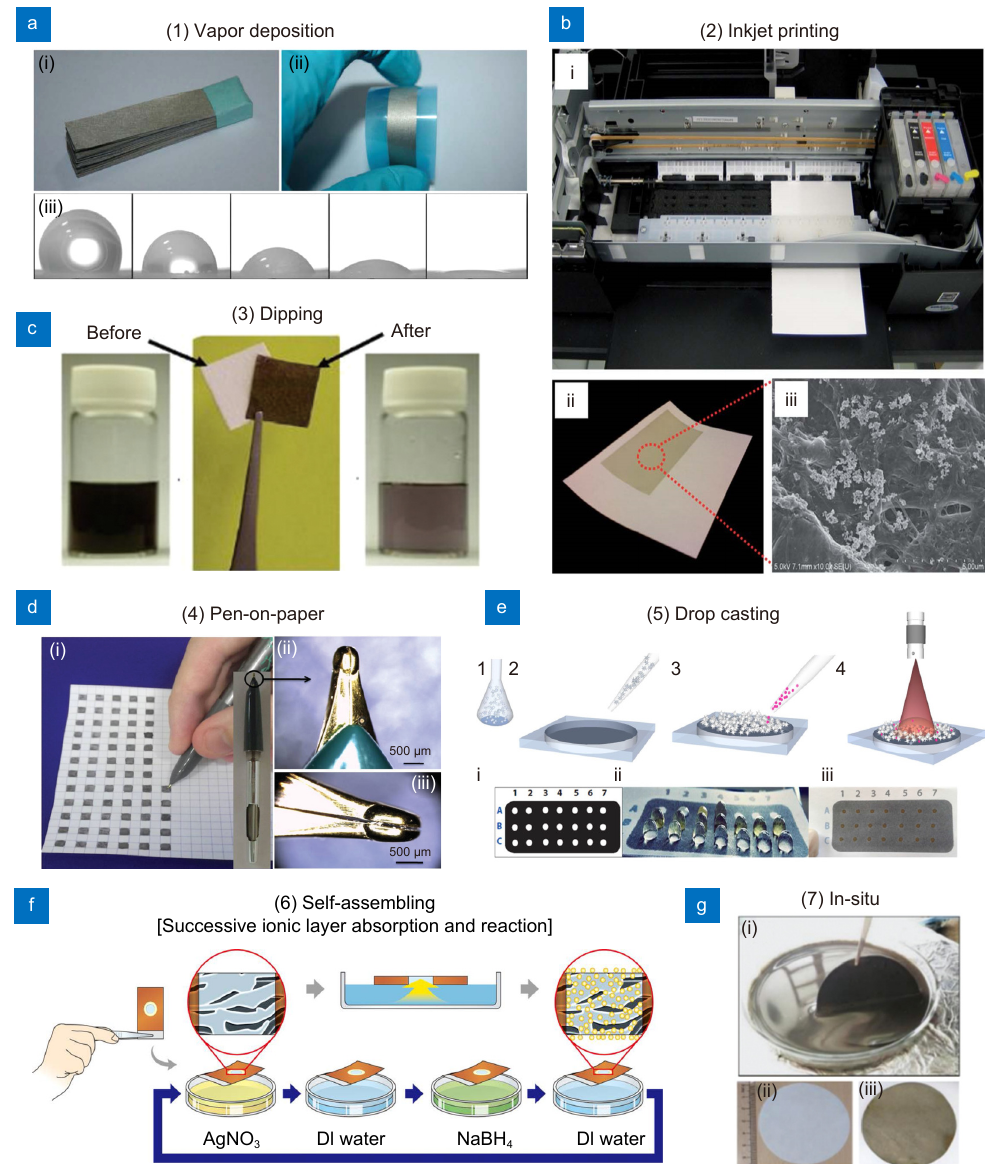
Fig. 5 | Various fabrication techniques used for paper-based SERS substrates. ( a ) Vapor deposition. ( b ) Inkjet printing. ( c ) Dipping. ( d ) Pen- on-paper. ( e ) Drop-casting on hydrophilic wells. ( f ) Self assembling. ( g ) In-situ reduction. Figure reproduced with permission from: (a) ref. 77 , (b) ref. 72 , The Royal Society of Chemistry; ref. 71 , American Chemical Society; (d) ref. 73 , John Wiley and Sons; (e) ref. 80 , Springer Nature; (f) ref. 84 , (g) ref. 79 , American Chemical